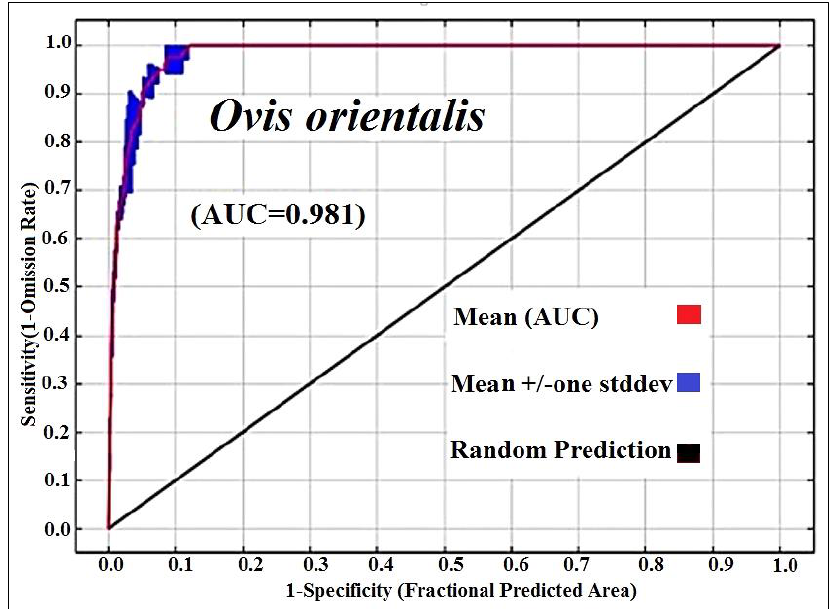
Figure 3. The ROC curve and AUC